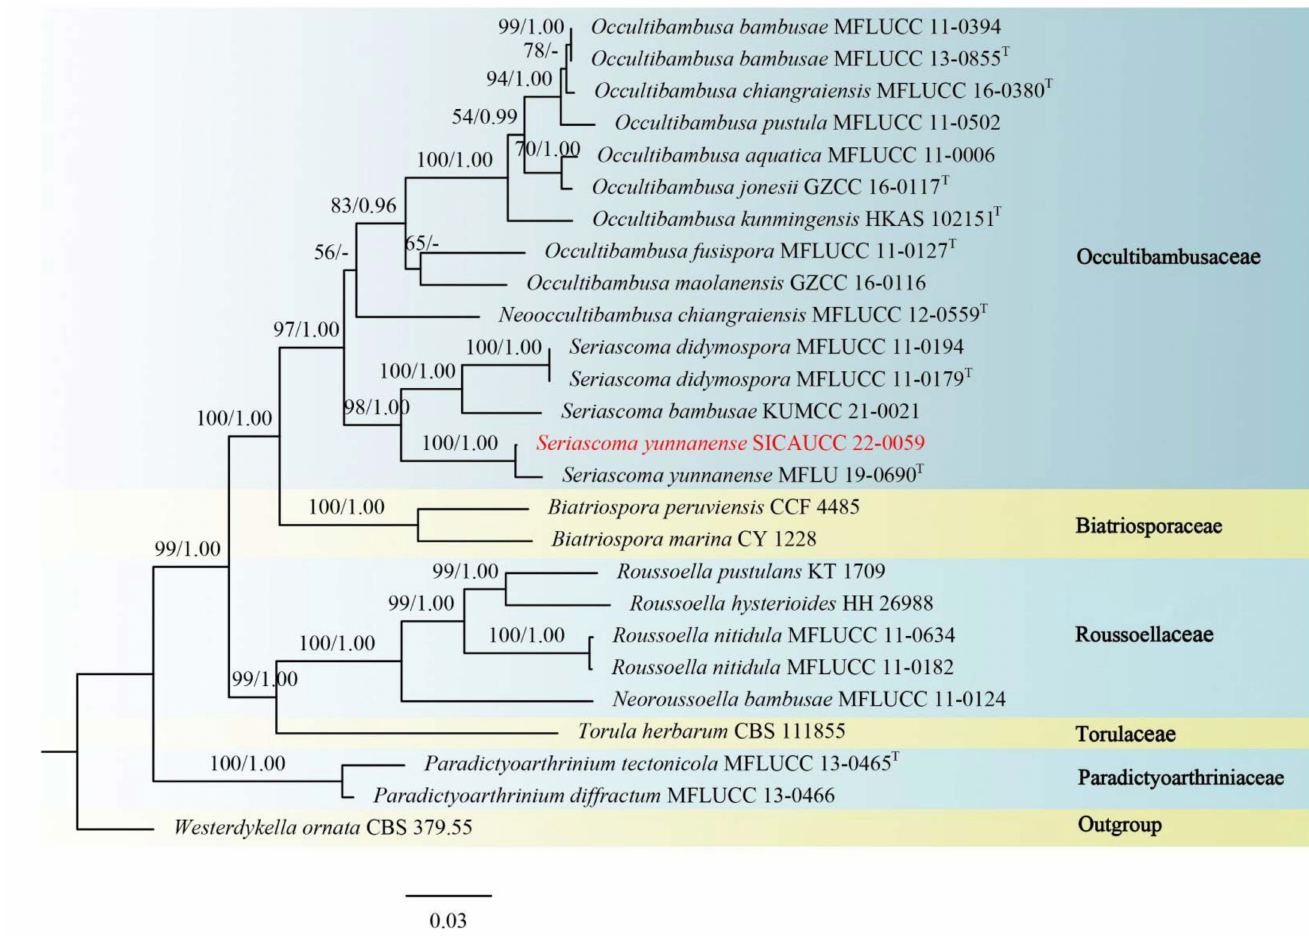
Figure 4. Phylogram generated from RAxML analysis based on combined ITS, LSU, rpb2, and tef1- α sequence data of isolates within Bambusicolaceae and other representative species in Biatriosporaceae, Roussoellaceae, Torulaceae, and Paradictyoarthriniaceae. Bootstrap support values for maximum likelihood (ML, left) higher than 50% and Bayesian posterior probabilities (BYPP, right) equal to or greater than 0.90 are indicated at the nodes, respectively. The sequences from ex-type strains are marked by a superscript symbol T. The newly generated sequence is written in